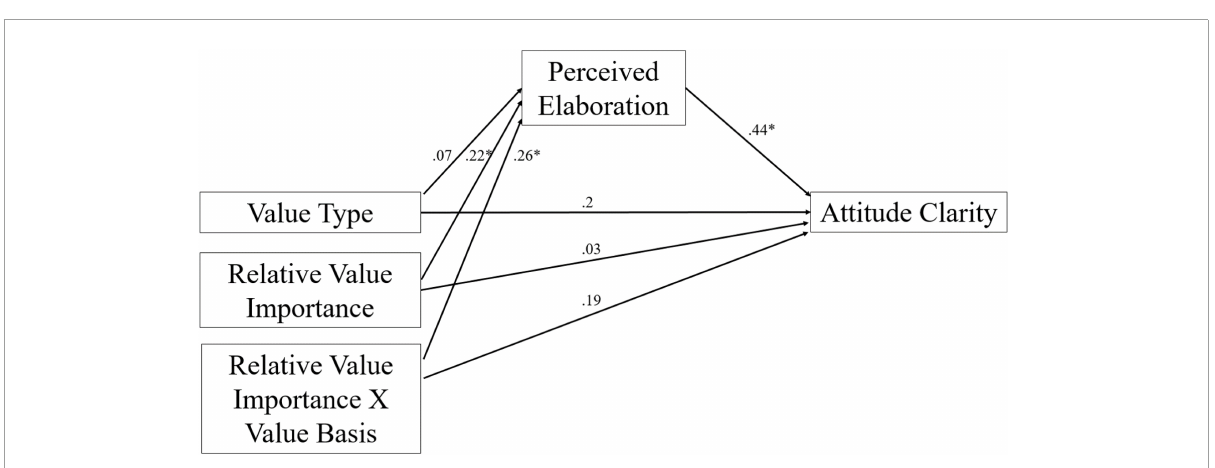
p = 0.08, 95% CI : [ − 0.03, 0.41]. Thus, perceived